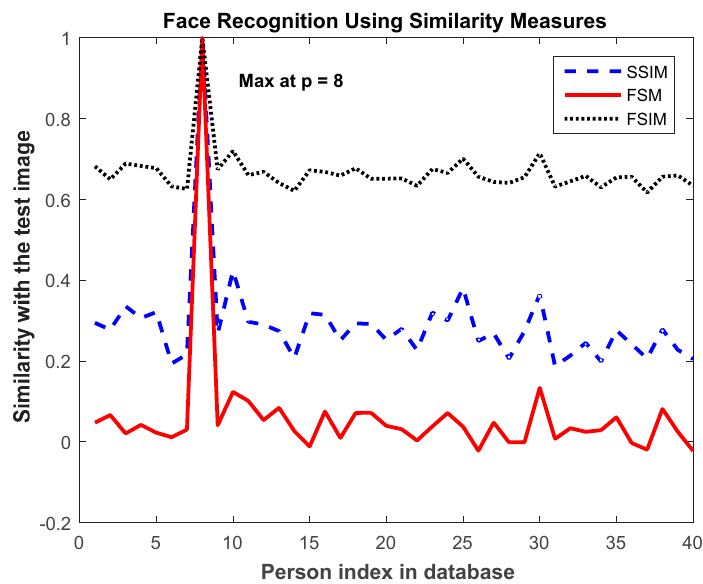
Figure 8. Performance of similarity measures using person No. 8 (pose 10) in the AT&T database. Confidence in recognition for SSIM, FSIM and FSM is 0.5773, 0.2803 and 0.8661 respectively.